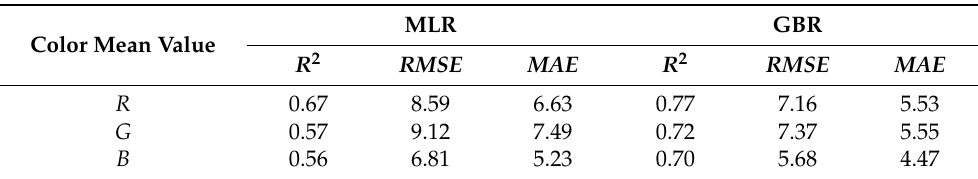
Table 3. Performance testing metrics of multiple linear regression (MLR) and gradient boosting regression (GBR)